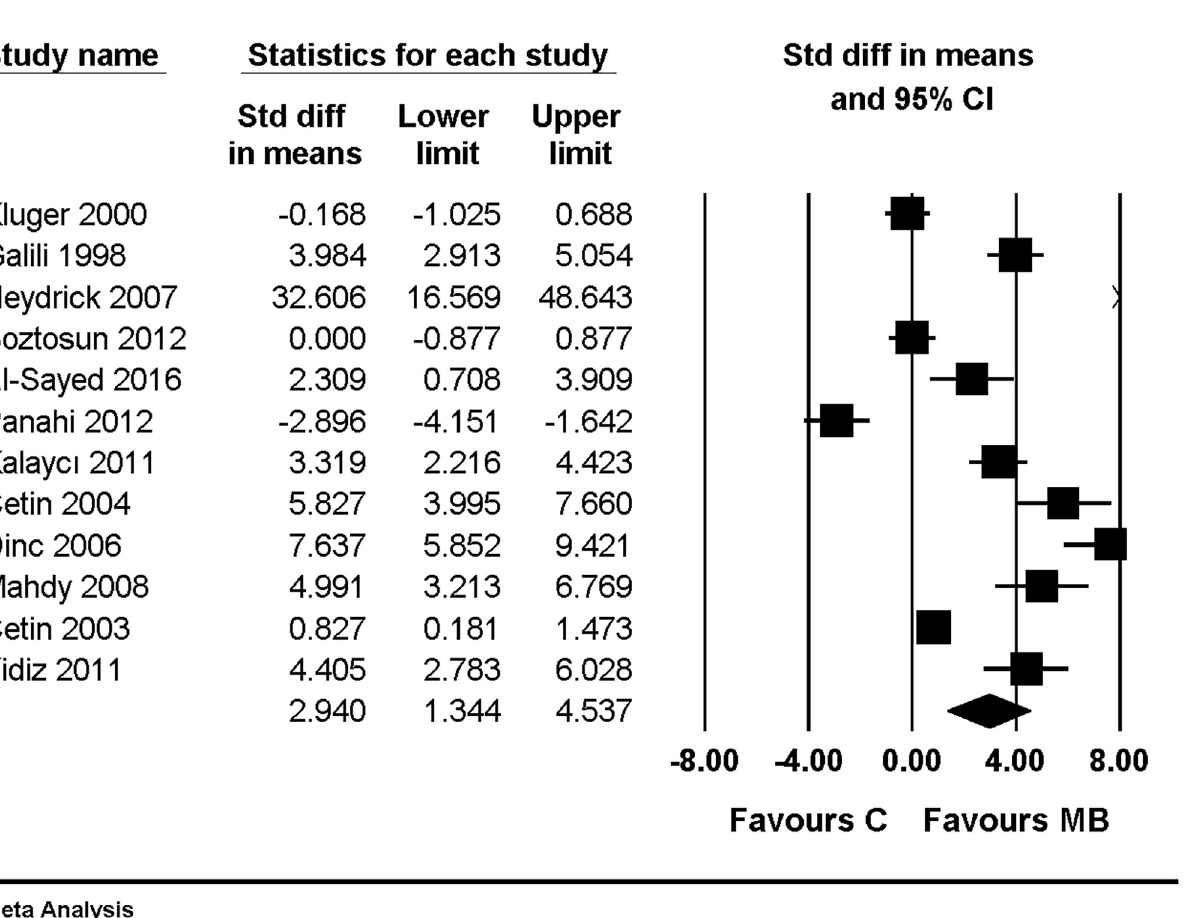
Fig 4. Forest plot showing an overall effect of macroscopic adhesion score compared with results of using saline as control. The figure depicts individual trials as filled squares with relative sample size and the 95% confidence interval (CI) of the difference as a solid line. The diamond shape indicates the pooled estimate and uncertainty for the combined